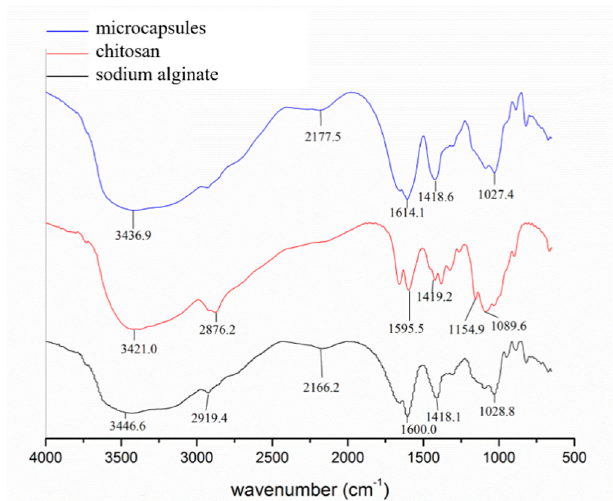
Figure 4. Infrared spectroscopy.